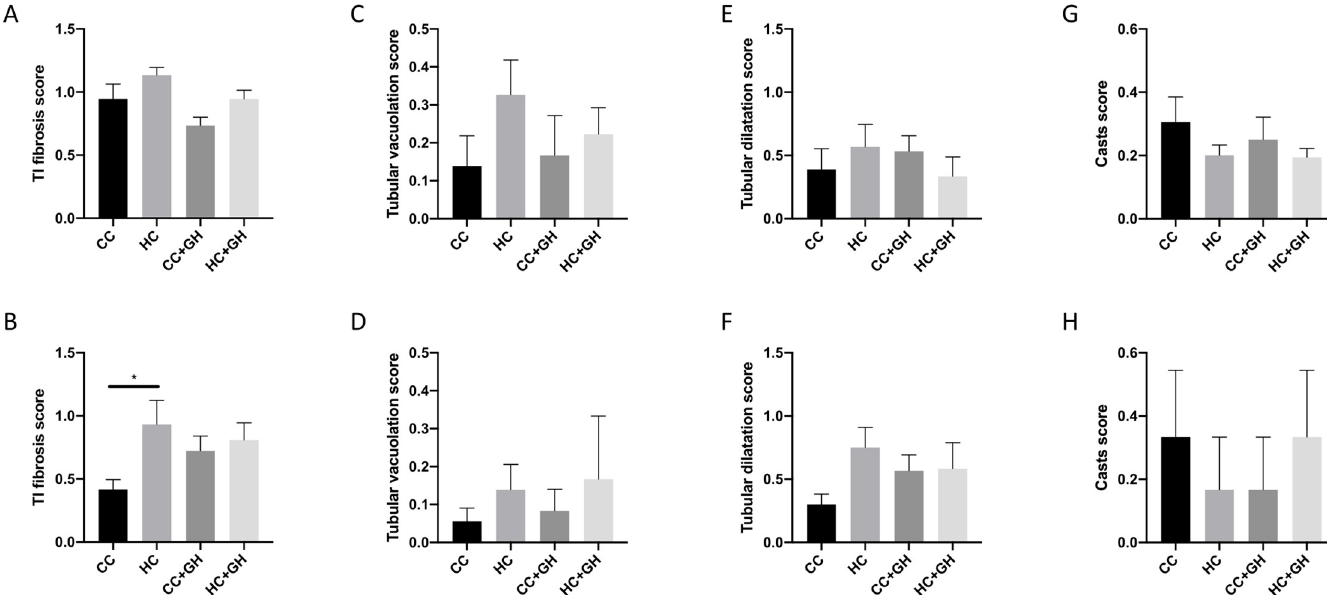
Fig 5. Renal structural changes. Kidneys assessed by PAS and Picrosirius Red staining. (A, B) Tubulointerstitial fibrosis assessment at week 9 and week 32, (C, D) tubular vacuolation assessment at week 9 and week 32, (E, F) tubular dilatation assessment at week 9 and week 32, (G, H) casts scoring at week 9 and week 32. Results expressed as mean ± SEM, n = 6. � p < 0.05.